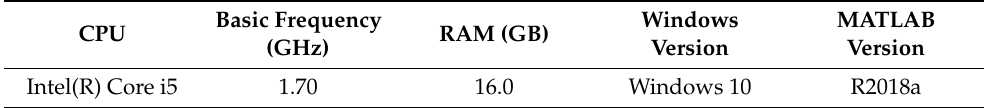
Table 2. Configuration